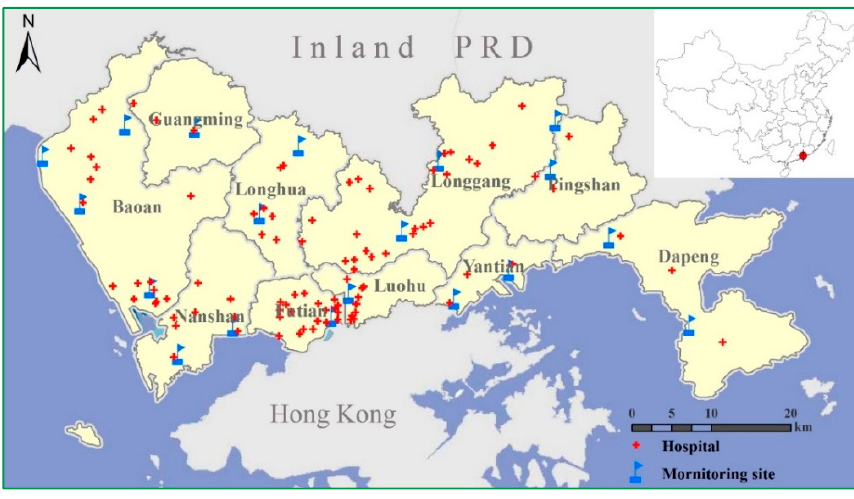
Figure 1. Locations of monitoring sites and hospitals in Shenzhen.